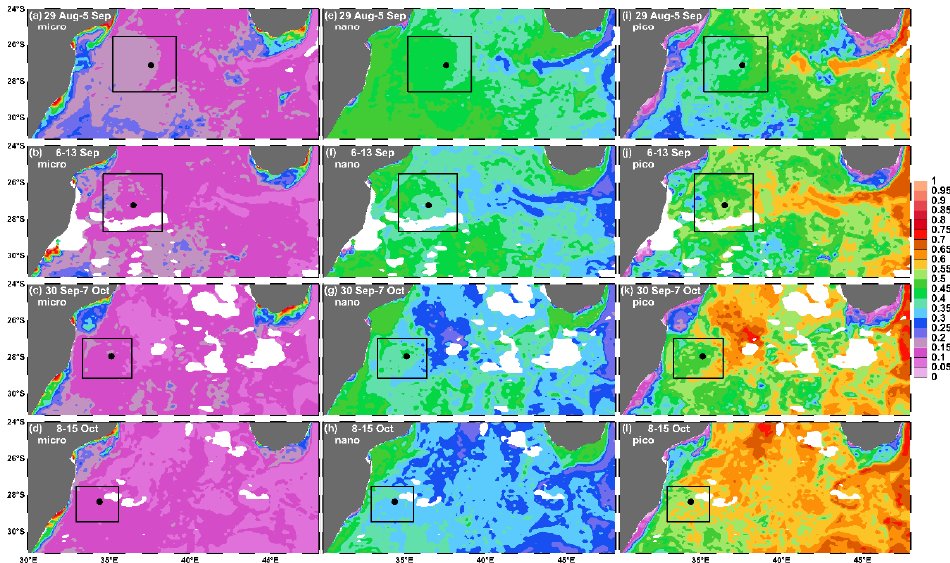
Figure 9. Fractional contribution of ( a – d ) micro-, ( e – h ) nano-, and ( i – l ) picophytoplankton to MODIS Aqua chlorophyll a for 29 August to 15 October 2013 over the Mozambique Basin. Black boxes highlight the location of the cyclonic eddy and black dots indicate the centre of the eddy. White areas indicate missing data due to cloud cover.